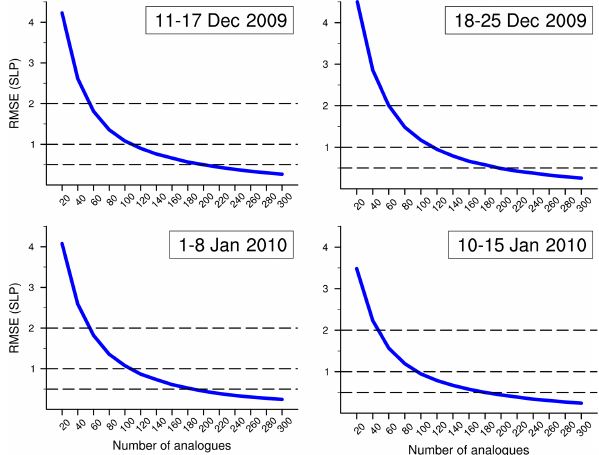
Figure A1. Accuracy (assessed by the RMSE, unit: hPa) of the SLP reconstruction as a function of the number of analogues used in the dynamical adjustment multilinear regression step. Four multi-day periods (dates in upper right corner) within the 2010 early winter European cold spell are considered to perform the sensitivity test. The RMSE is first estimated at each grid point and then averaged over the 30–75 ◦ N, 25 ◦ W–40 ◦ E geographical box with latitudinal weighting.